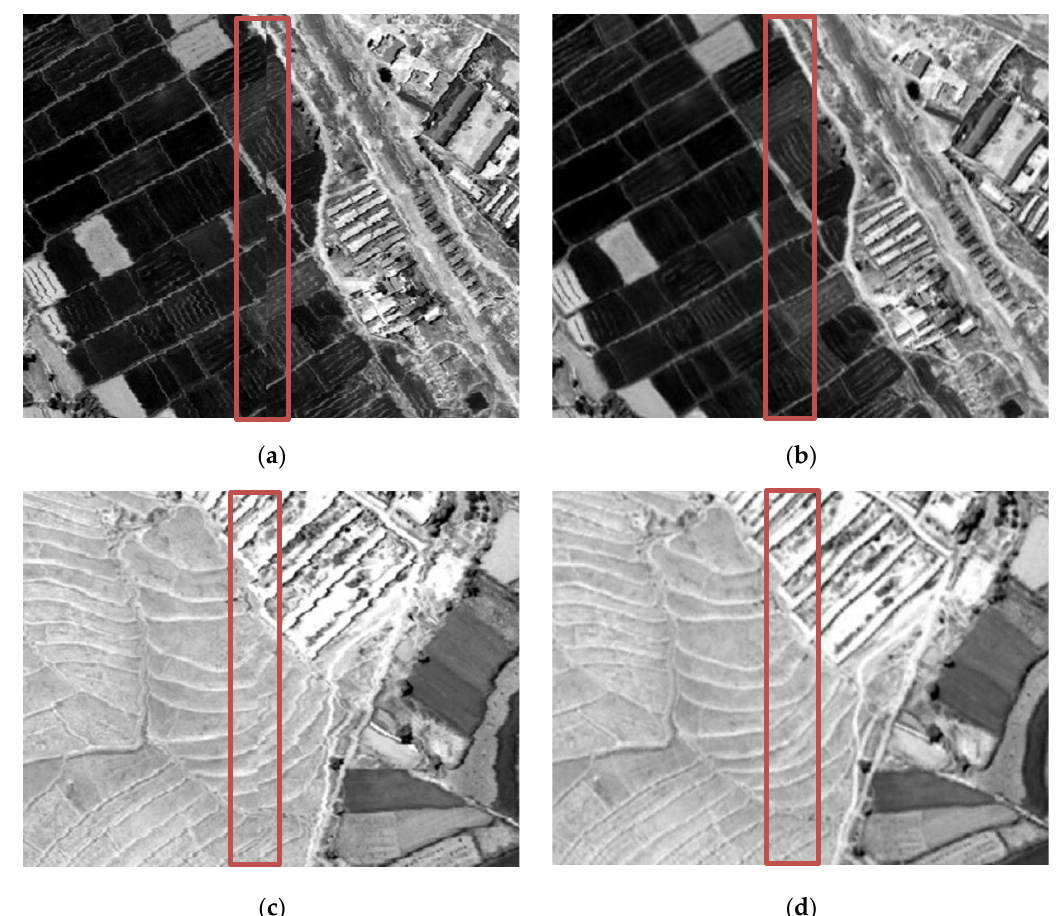
Figure 13. Experimental results in unstable flight condition: ( a ) original and ( b ) updated overlapping area between left and middle images; ( c ) original and ( d ) updated overlapping area between middle and right images. The red rectangular frames the seamline between two adjacent images before and after stitching.